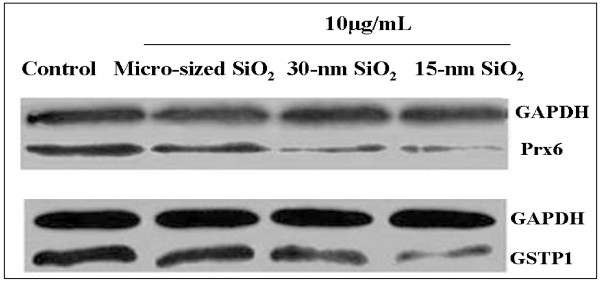
The changes of Prx6 and GSTP expression induced by SiO2 exposure Western-blot showed the change of Prx6 and GSTP1. The representative bands from three independent experiments were shown.